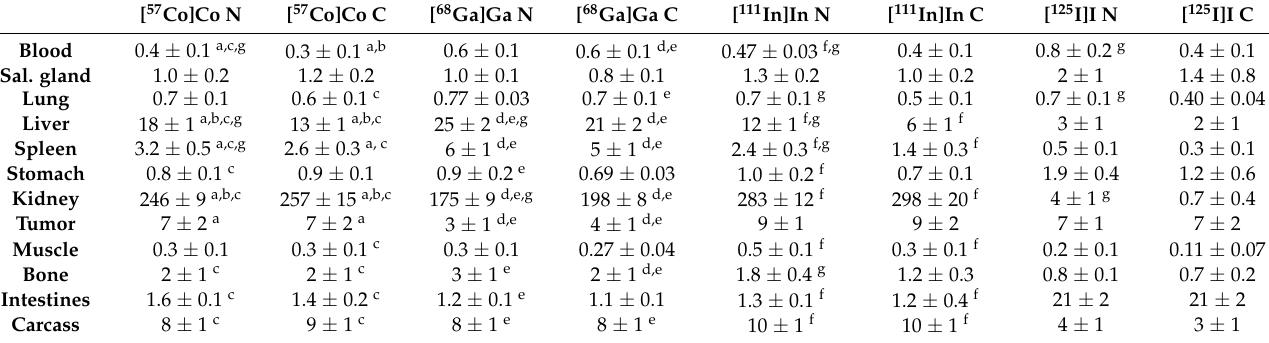
a Significant difference ( p < 0.05) between [ 57 Co]Co and [ 68 Ga]Ga. b Significant difference ( p < 0.05) between [ 57 Co]Co and [ 11 1In]In. c Significant difference ( p < 0.05) between [ 57 Co]Co and [ 125 I]I. d Significant difference ( p < 0.05) between [ 68 Ga]Ga and [ 111 In]In. e Significant difference ( p < 0.05) between [ 68 Ga]Ga and [ 125 I]I. f Significant difference ( p < 0.05) between [ 111 In]In and [ 125 I]I. g Significant difference ( p < 0.05) between N - and C -terminal placement of the label (unpaired t